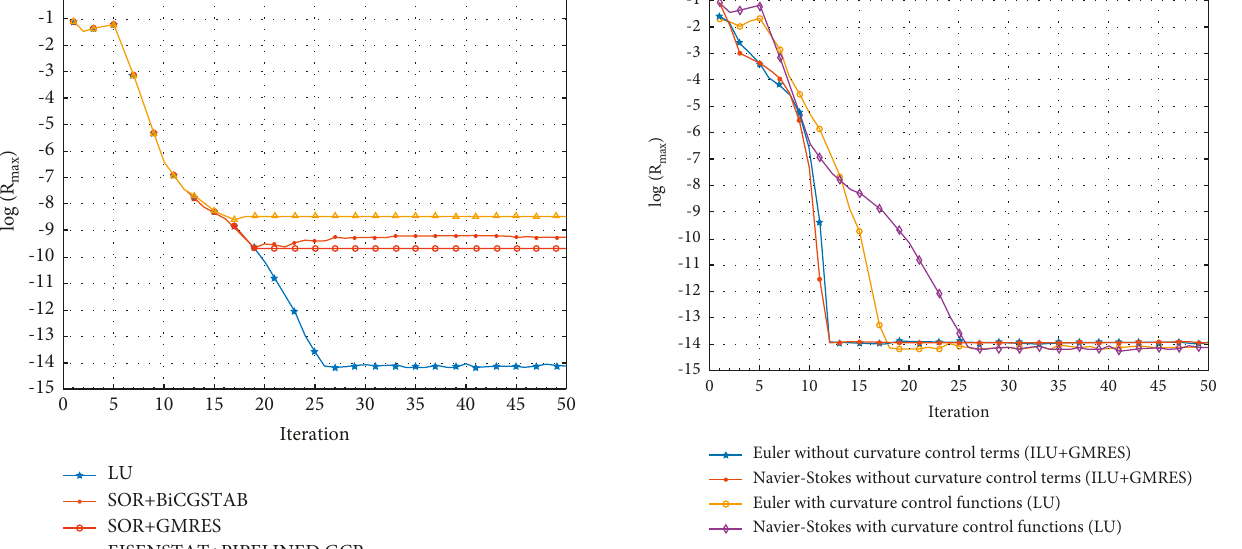
Figure 19: Convergence rates vs. iteration, with and without curvature functions.